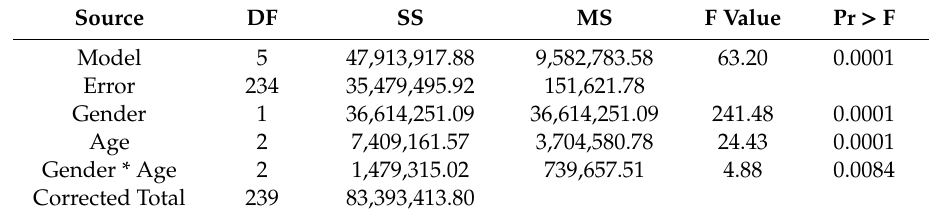
Table 7. The results of the two-way ANOVA for whole-body BMC of males and females according to age.